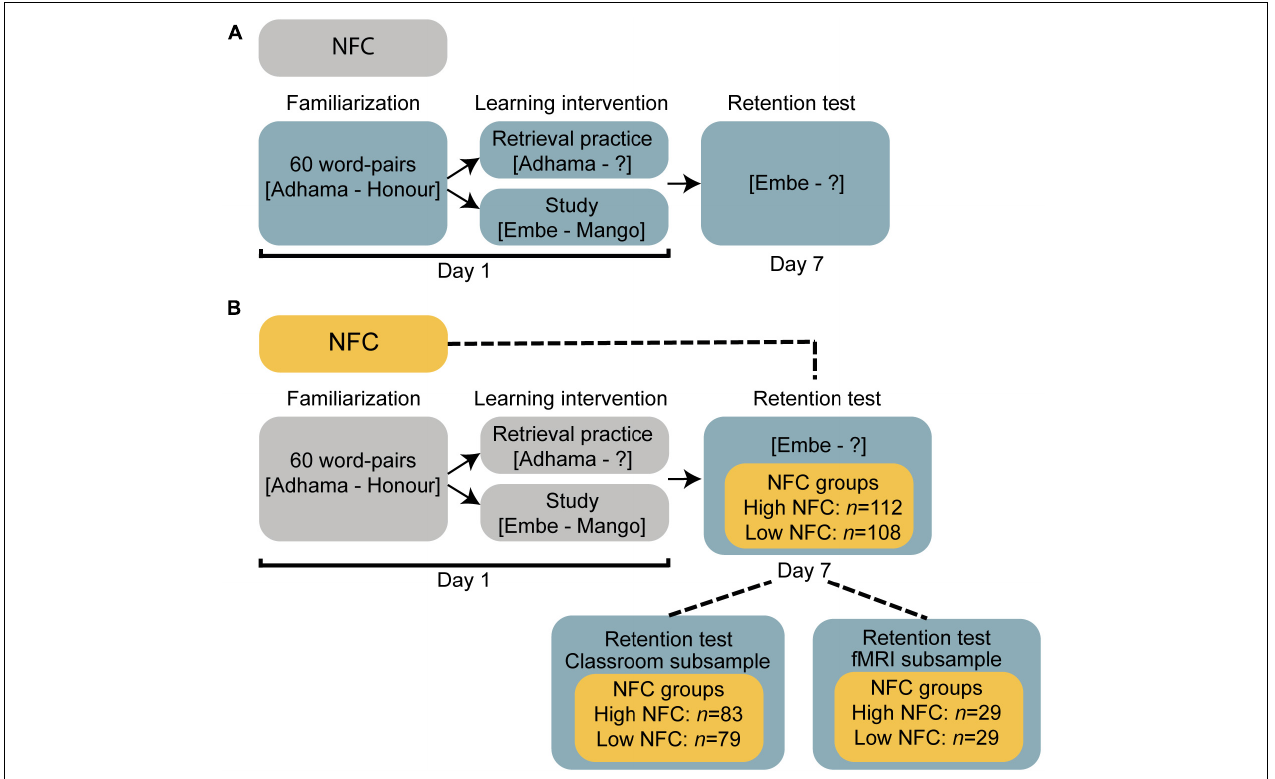
FIGURE 1 | A schematic overview over the (A) overall study design and (B) related to the low and high NFC groups